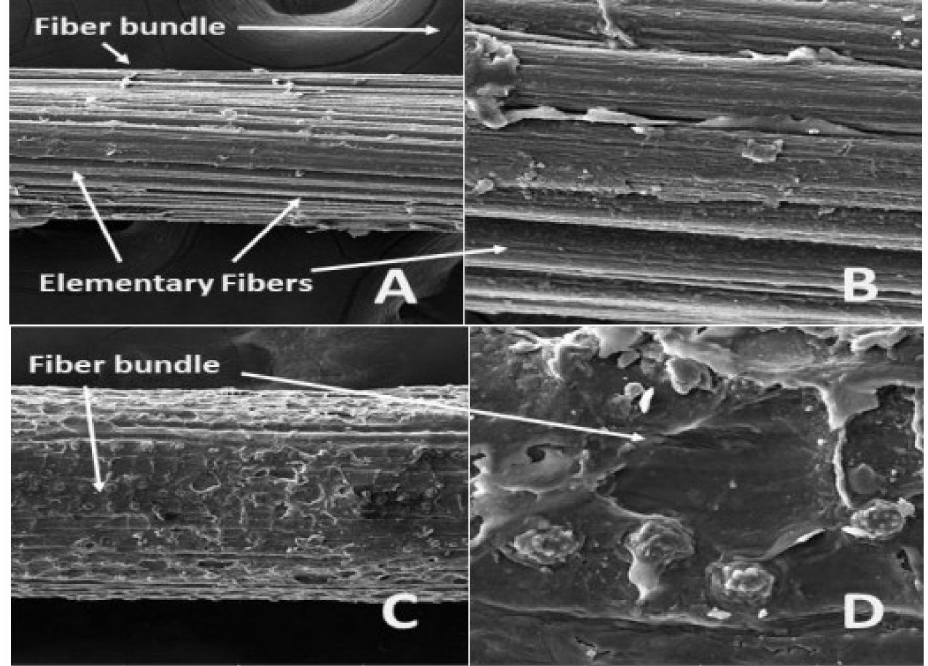
Figure 15. SEM images of 5%-NaOH-treated abaca and coir fibers: ( A ) abaca fiber bundle (@ mag 750 x), ( B ) abaca fiber detailed surface view (@ mag 3.5 kx), ( C ) coir fiber bundle (@ mag 750 x), and